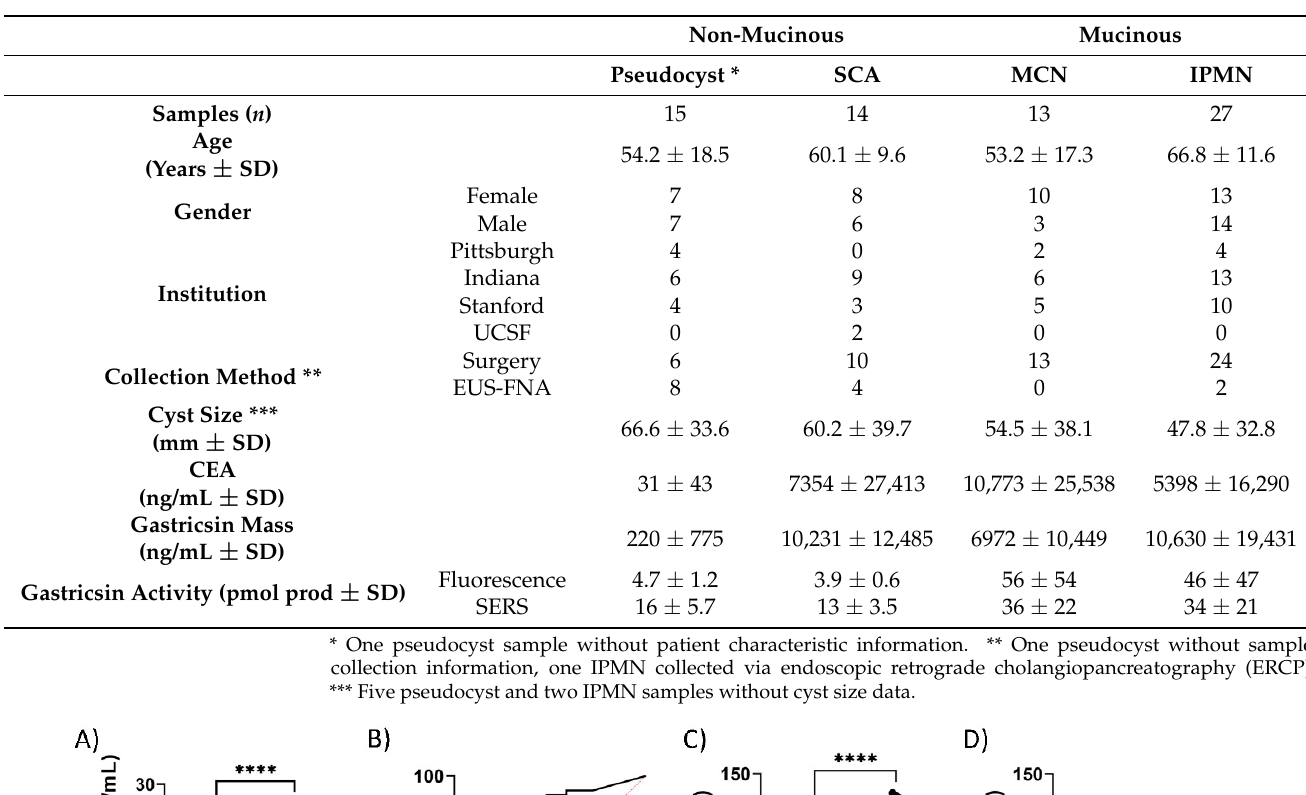
Table 1. n = 69 clinical sample cohort characteristics. Units are as listed in the row heading.